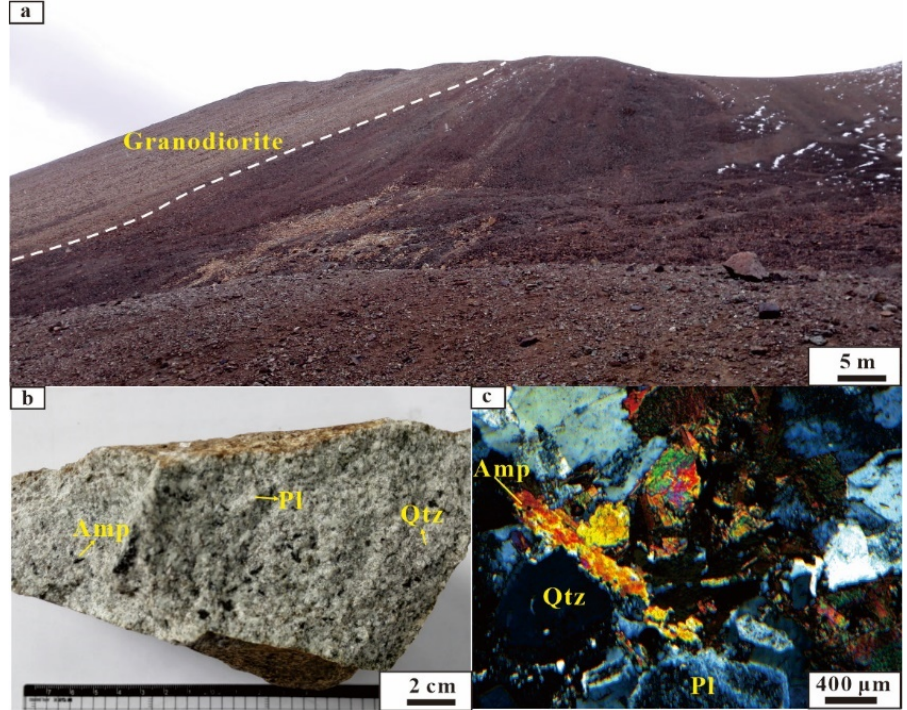
Figure 3. Outcrop photograph ( a ), typical hand specimen photographs ( b ), and microphotographs ( c ) of Nuocang granodiorite. Amp—amphibole; Pl—plagioclase; Qtz—quartz.